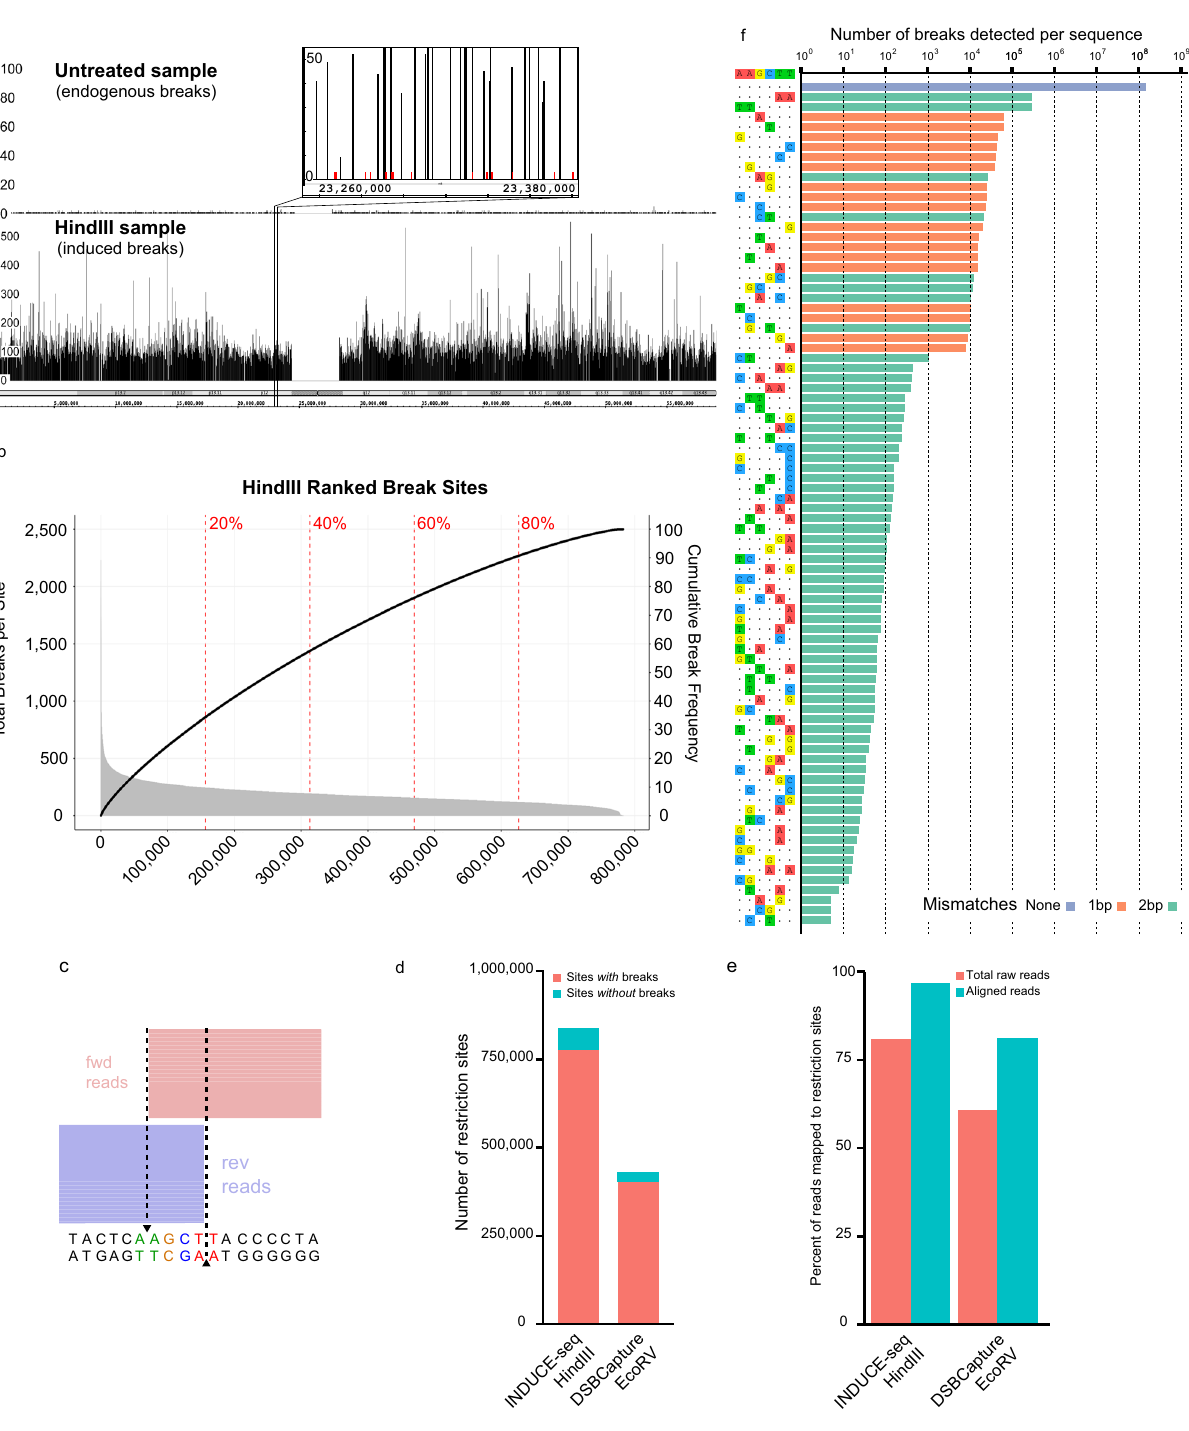
detected the presence of breaks at ~230 AsiSI sites, expanding the DSB spike-in) when using these methods. Importantly, this AsiSI sites discovered in live cells compared to the 214 sites improvement in AsiSI site detection was achieved despite reported by BLISS, and 121 sites reported by DSBCapture. It is sequencing 40-fold fewer reads than a comparable DSBcapture important to note the difference between the raw sequencing experiment, and 23-fold fewer reads compared to a BLISS output observed between these methods, which is enabled by the experiment 17,21 . This demonstrates that INDUCE-seq is sig- ni fi cantly more sensitive, ef fi cient, and cost effective than these characteristics of INDUCE-seq (Fig. 3a). Figure 3a (bottom two other methods (Fig. 3b). panels) demonstrates the effect of PCR ampli fi cation on DSB INDUCE-seq is designed to capture DNA double strand breaks sequencing output, which uncouples the relationship between in direct proportion to their frequency of occurrence within the breaks labelled in the cell and reads sequenced. This explains the starting cell population. Because each sequencing read obtained is need for some form of error-correction (e.g. UMI correction or NATURE COMMUNICATIONS| (2022) 13:3989